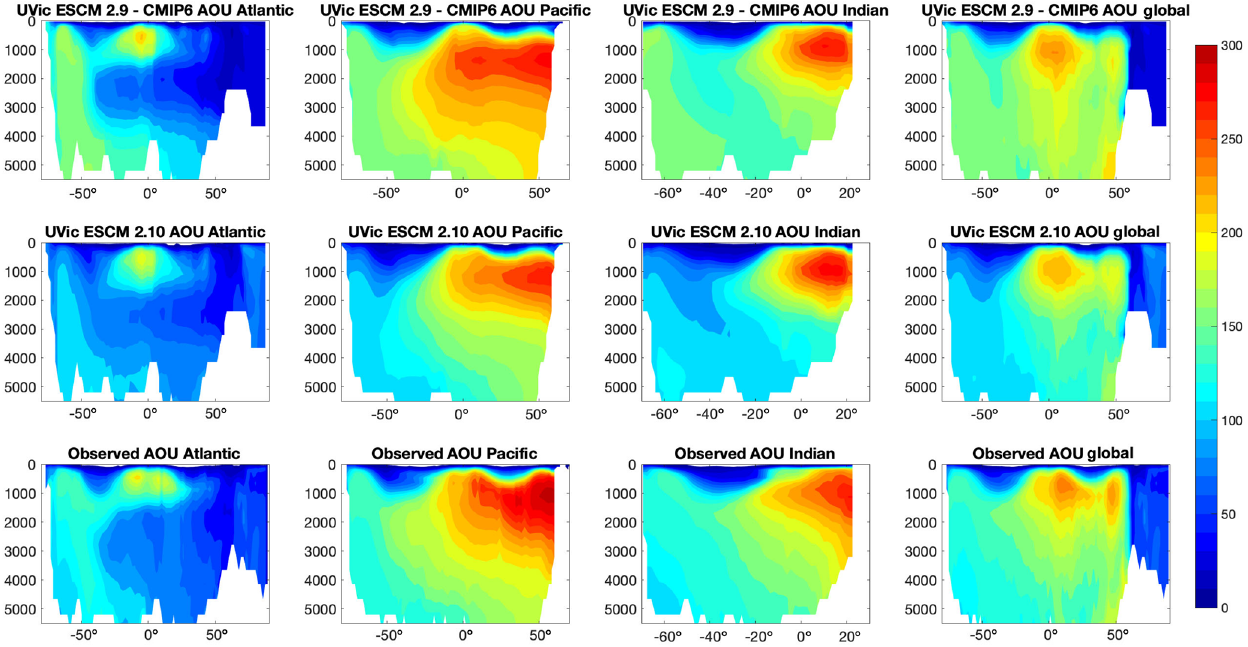
Figure 15. Ocean section of apparent oxygen utilization (AOU) (in µmolkg − 1 ) for the Atlantic Ocean including the Arctic Ocean (left column), the Pacific Ocean (middle left column), the Indian Ocean (middle right column) and the global average (right column) compared to the World Ocean Atlas 2018 (Garcia et al., 2019). From top to bottom, what is shown are the published UVic ESCM version 2.9 by Eby et al. (2013) spun up and forced with CMIP6 forcing, the UVic ESCM version 2.10, both as a mean of the period 1980–2010, and the observed ocean sections.